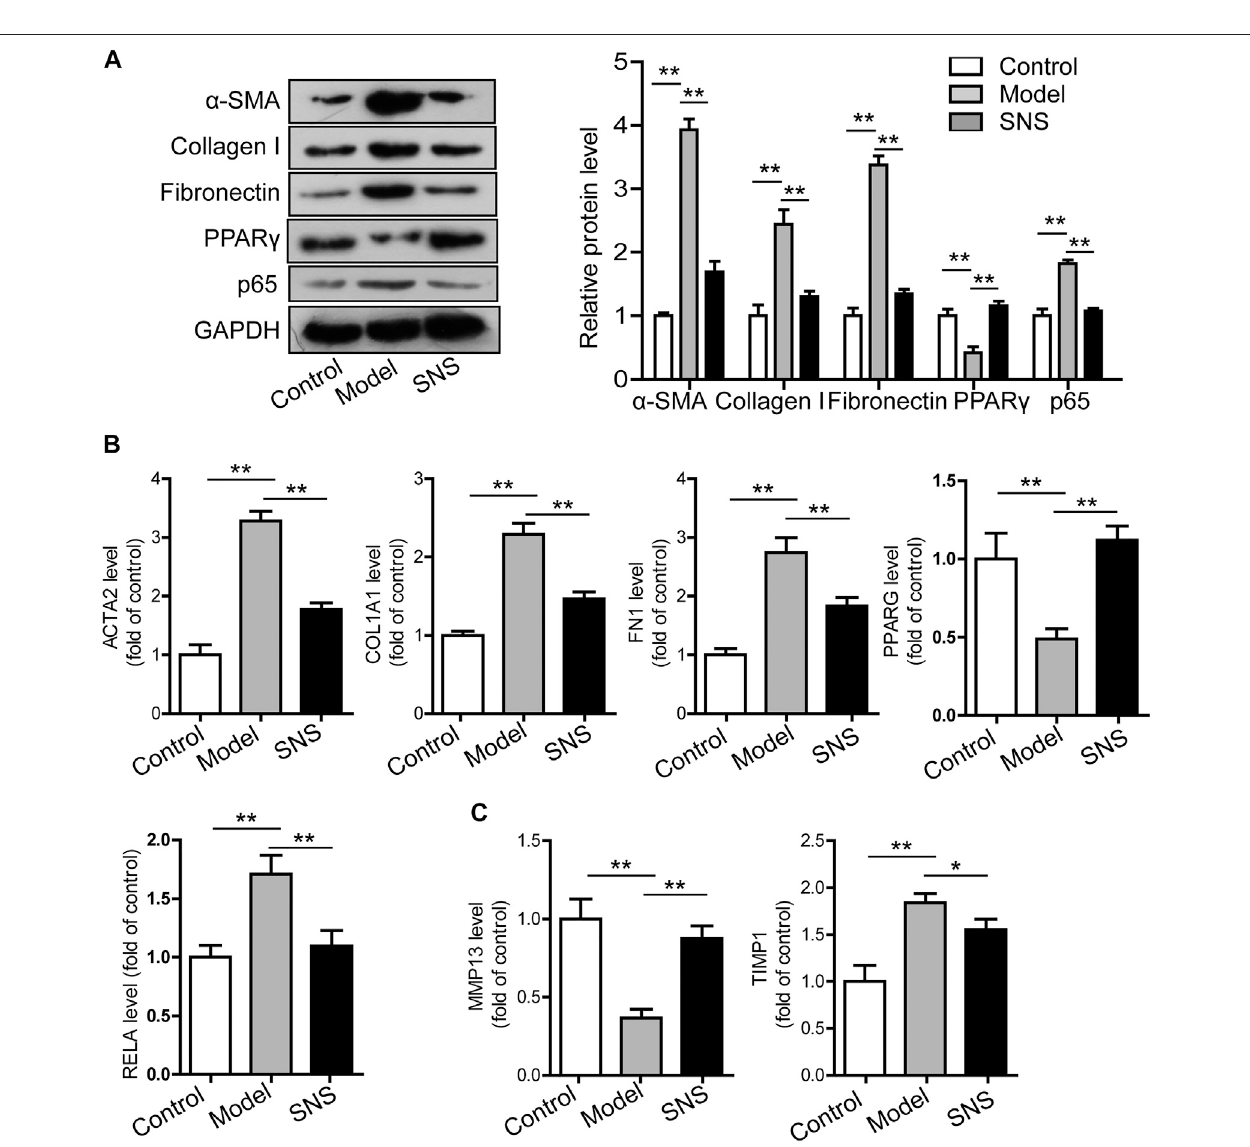
FIGURE 8 | SNS reverses activation of HSCs through modulating PPAR- γ and NF- κ B p65. (A) Effects of SNS on protein levels of α -SMA, collagen I, fi bronectin, p65 and PPAR γ in activated LX2 cells. (B) Effects of SNS on mRNA levels of ACTA2, COL1A1, FN1, PPARG and RELA in activated LX2 cells. (C) Effects of SNS on MMP13 and TIMP1 mRNA levels in activated LX2